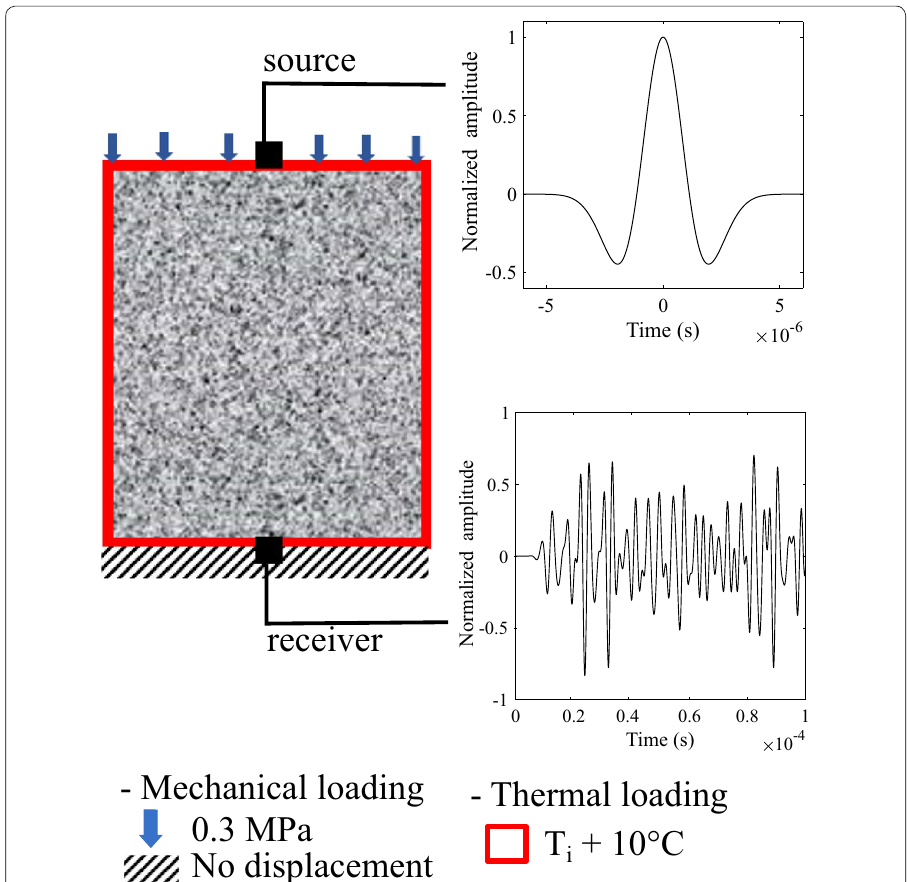
Fig. 3 Illustration of the principle of the numerical approach. Using a finite element method ( Code_Aster ), we apply a thermal and mechanical loading, step by step, to the numerical sample chosen to be of same size as the experimental sample (40 20 mm). During each step, the mechanical loading is a 0.3 MPa vertical stress × and the thermal loading is a constant temperature at the borders. Temperature is increased by steps of 10 ° C. The wave propagation is computed using a spectral element method (SPECFEM2D). A Ricker wavelet (see top-right insert) is emitted in the medium from the source (top) and recorded at the opposite side (bottom) by a virtual 32-sensor receiver